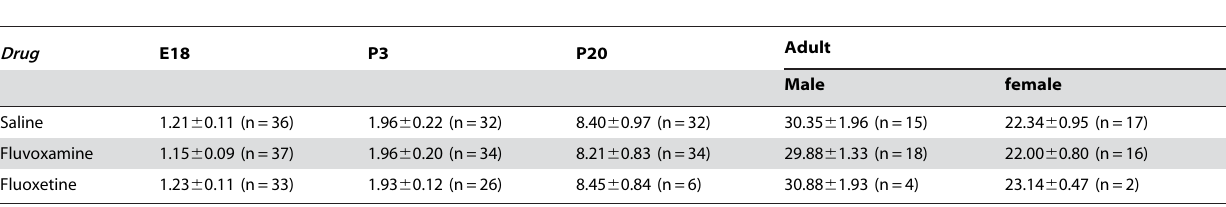
Table 1. Body weight during postnatal development and between treatment